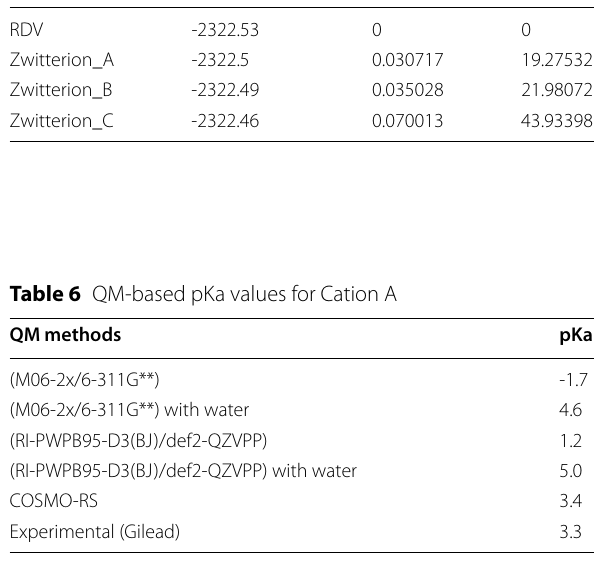
Table 5 The lowest configuration energy of different neutral states Structure